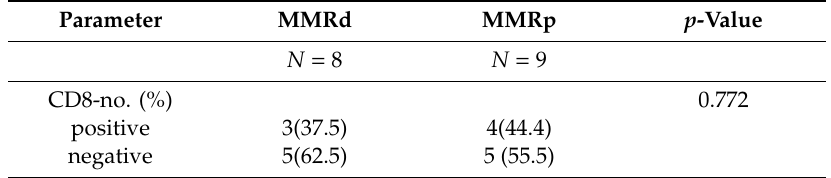
Table 4. Relationship between status of MMR and CD8 expression. (well di ff erentiated